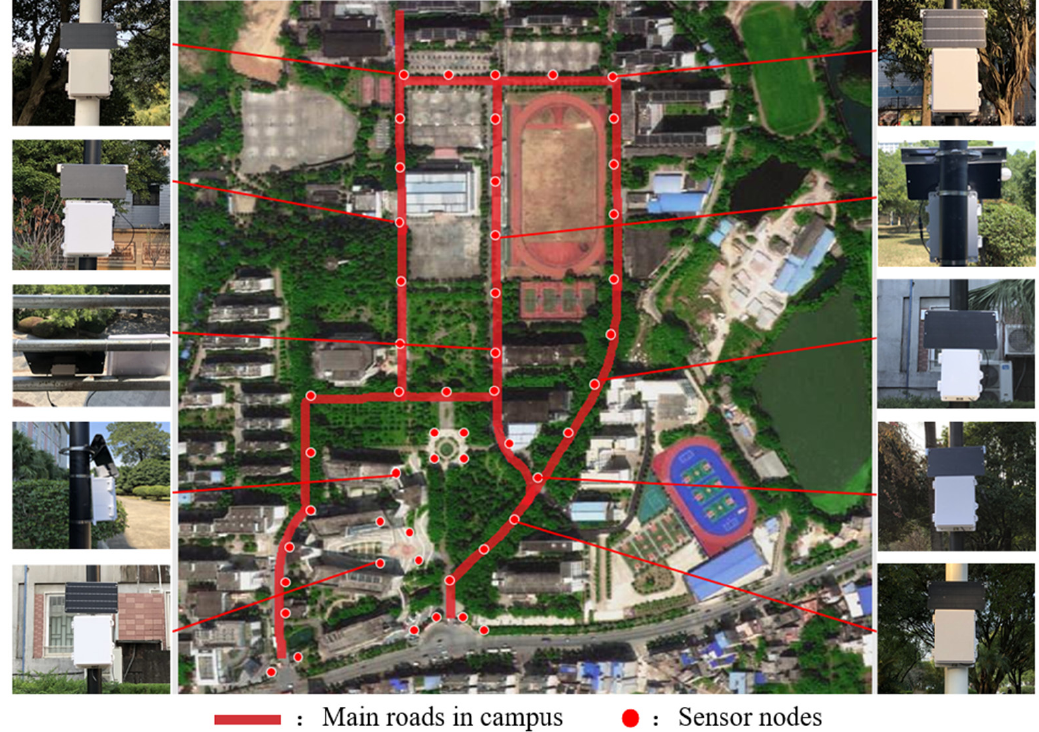
Table 5. Time-consuming of feature extraction and recognition.